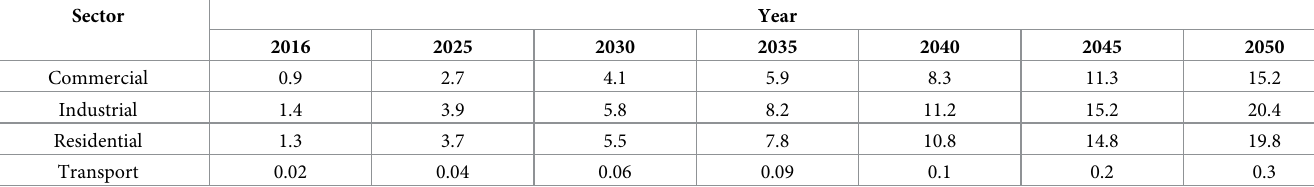
Table 10. Existing and predicted the energy demand (10 3 GWh) for the city.